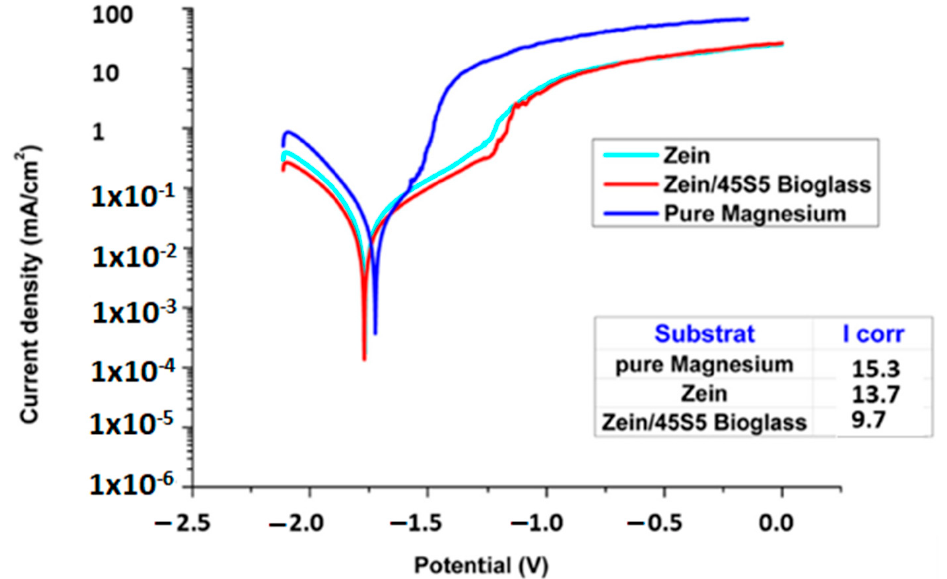
Figure 18. Polarization curves for pure Mg and coated samples. Reproduced from [87].